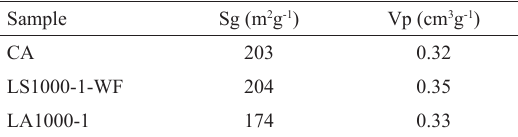
Table 1: Specific surface area values (Sg) and pore volume values (Vp) of the calcined samples at 800 o